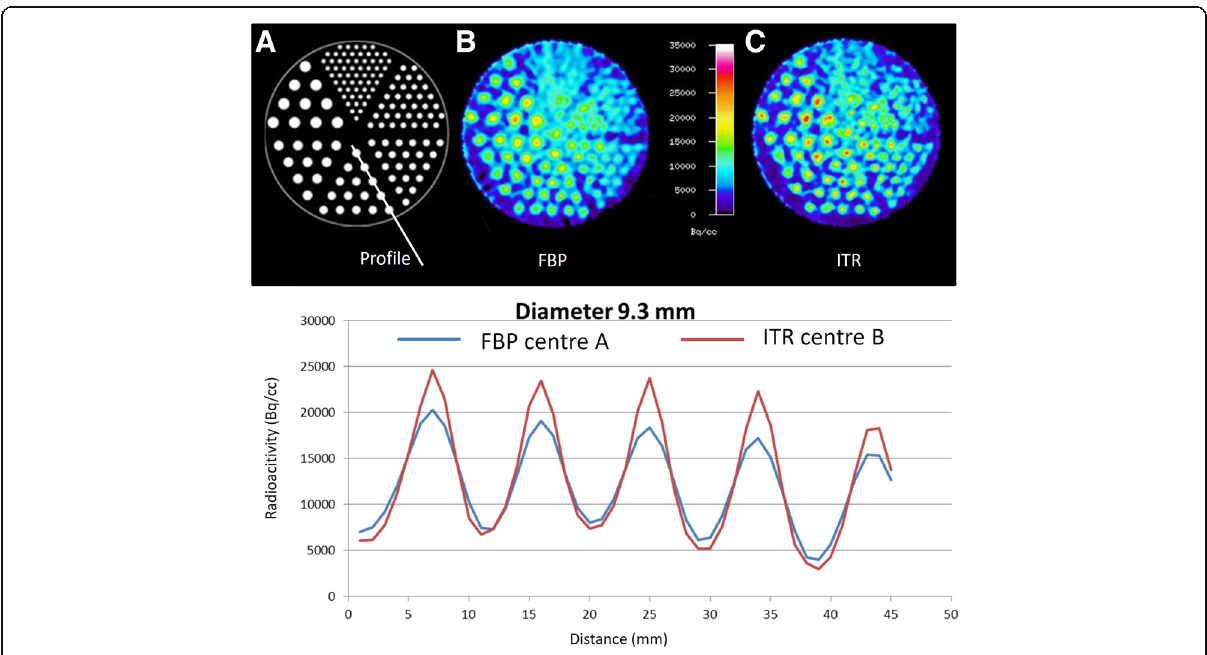
Fig. 2 Jasczack phantom ( a ) with tubes of different size filled with radioactivity and reconstructed according to the procedure in centre A ( b , blue profile line) and centre B ( c , red profile line). The method of centre A shows about 20% lower maximum values in the tubes with a diameter of 9.3 mm which is mainly due to reconstruction by filtered back projection in centre A instead of iterative reconstruction (centre B